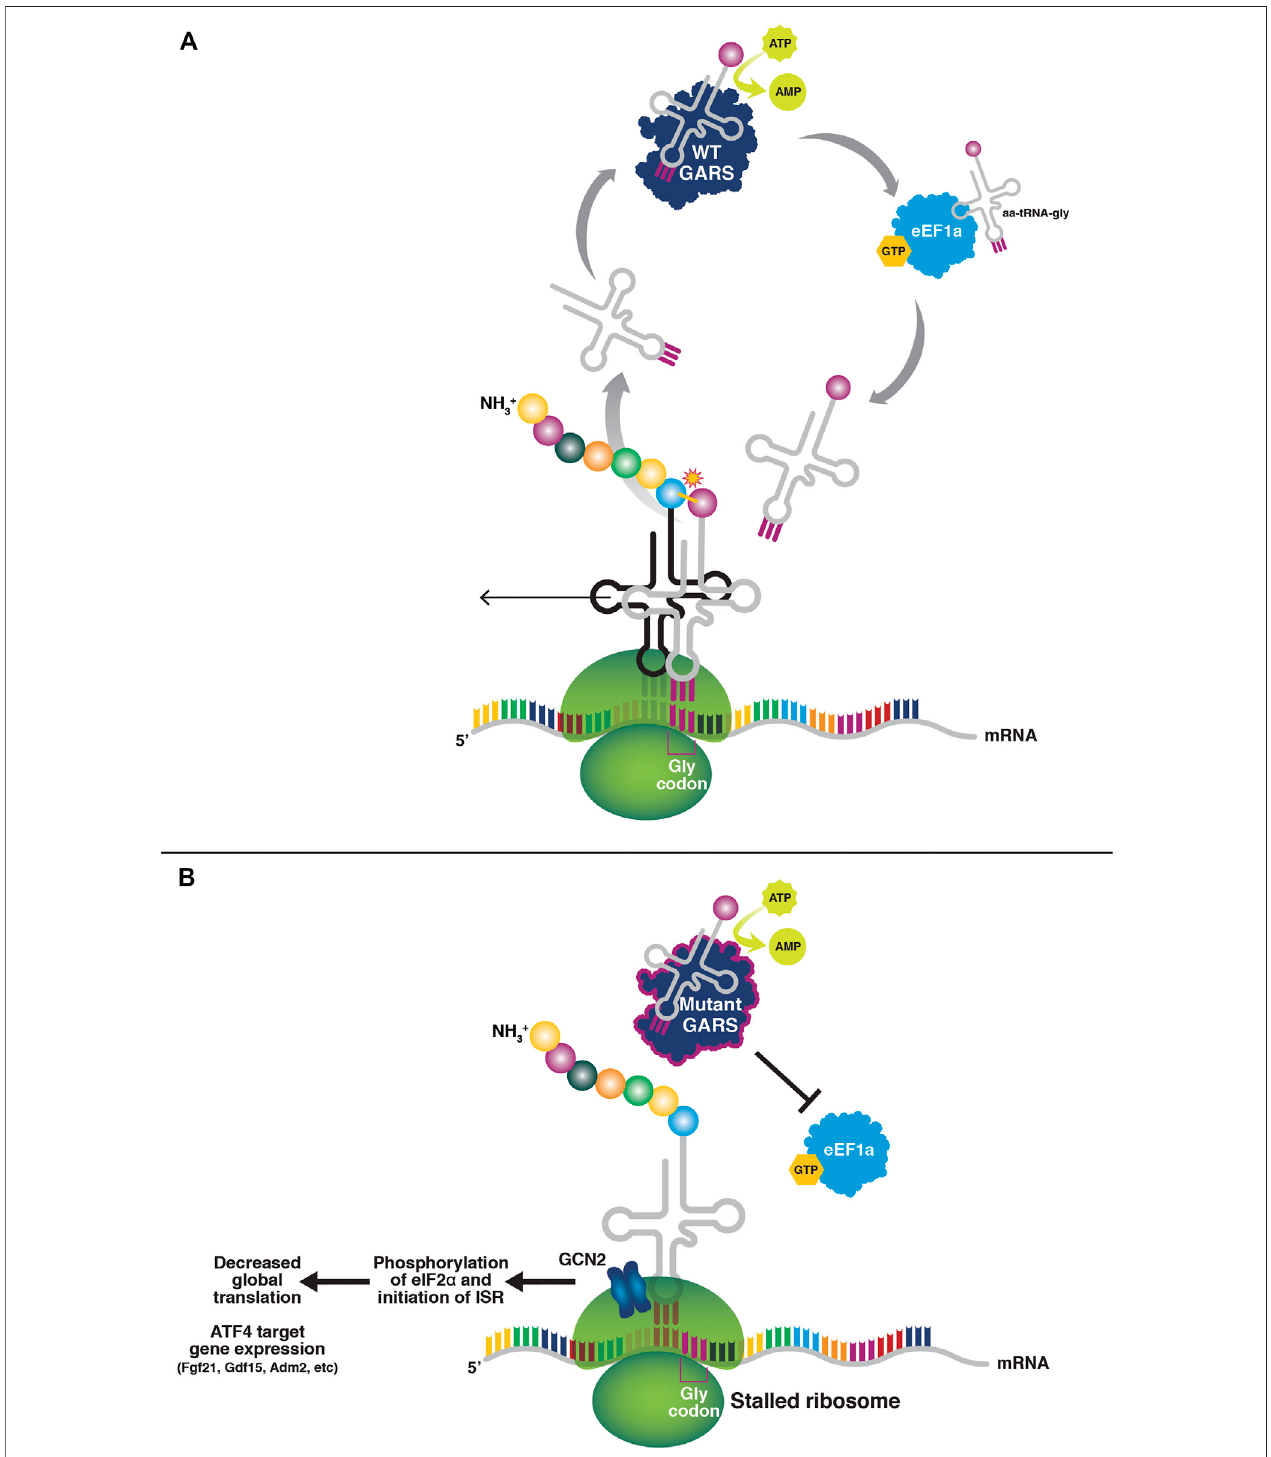
FIGURE 1 | tRNA sequestration by mutant tRNA synthetases. (A) In normal tRNA charging, the amino acid binds the tRNA synthetase and is coupled with ATP to formanaminoadenylateintermediate.Theaminoacidisthenchargedontothe3 ′ endofthecognatetRNA.Theaminoacid-chargedtRNAisshuttledtotheribosomeby eEF1A to participate in translation. (B) Mutant tRNA synthetases do not release the tRNAs to eEF1A, thus resulting in a paucity of charged tRNAs for translation elongation and subsequently ribosome stalling at Glycine codons (in the case of mutant glycyl tRNA-synthetase). The stalled ribosomes activate GCN2 and the integrated stress response, resulting in a suppression of global cap-dependent translation through eIF2 α phosphorylation, and activation of ATF4 target gene expression.